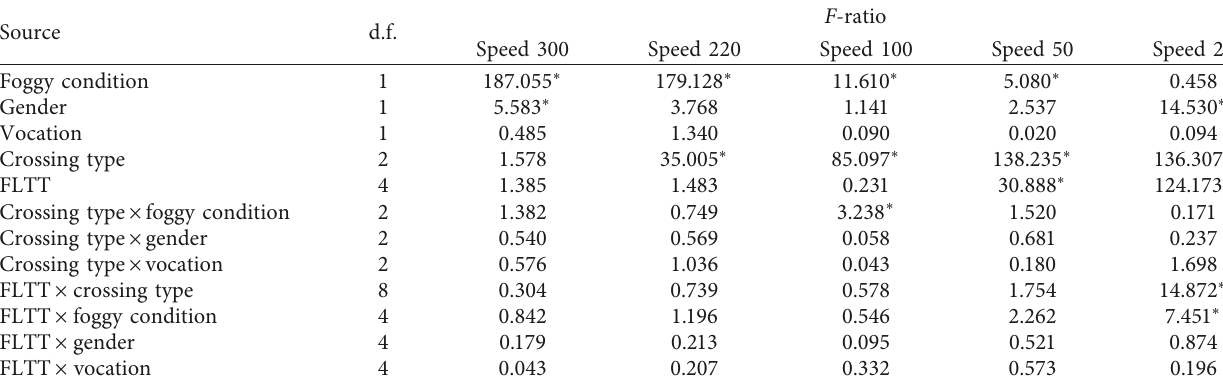
Table 3: ANOVA summary table of the effect of factors on approaching mean